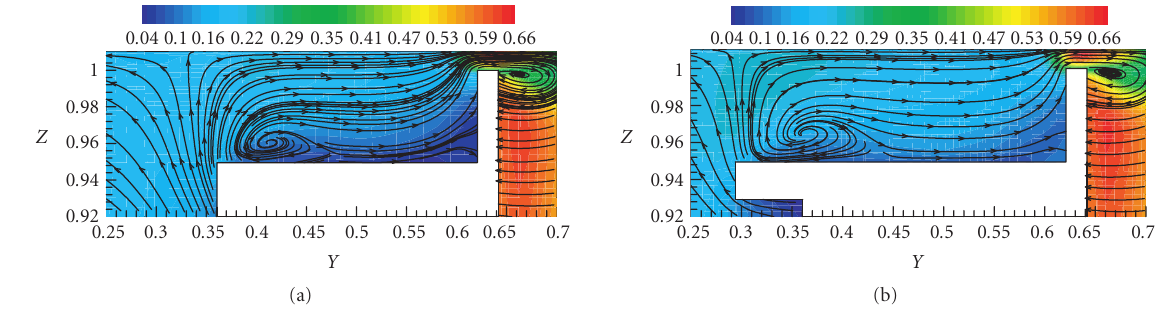
Figure 17: Secondary flow distribution superimposed on the Mach number contour at a streamwise location of 40% from leading wall of the blade, (a) baseline suction-side squealer tip and (b) desensitized suction-side squealer tip.